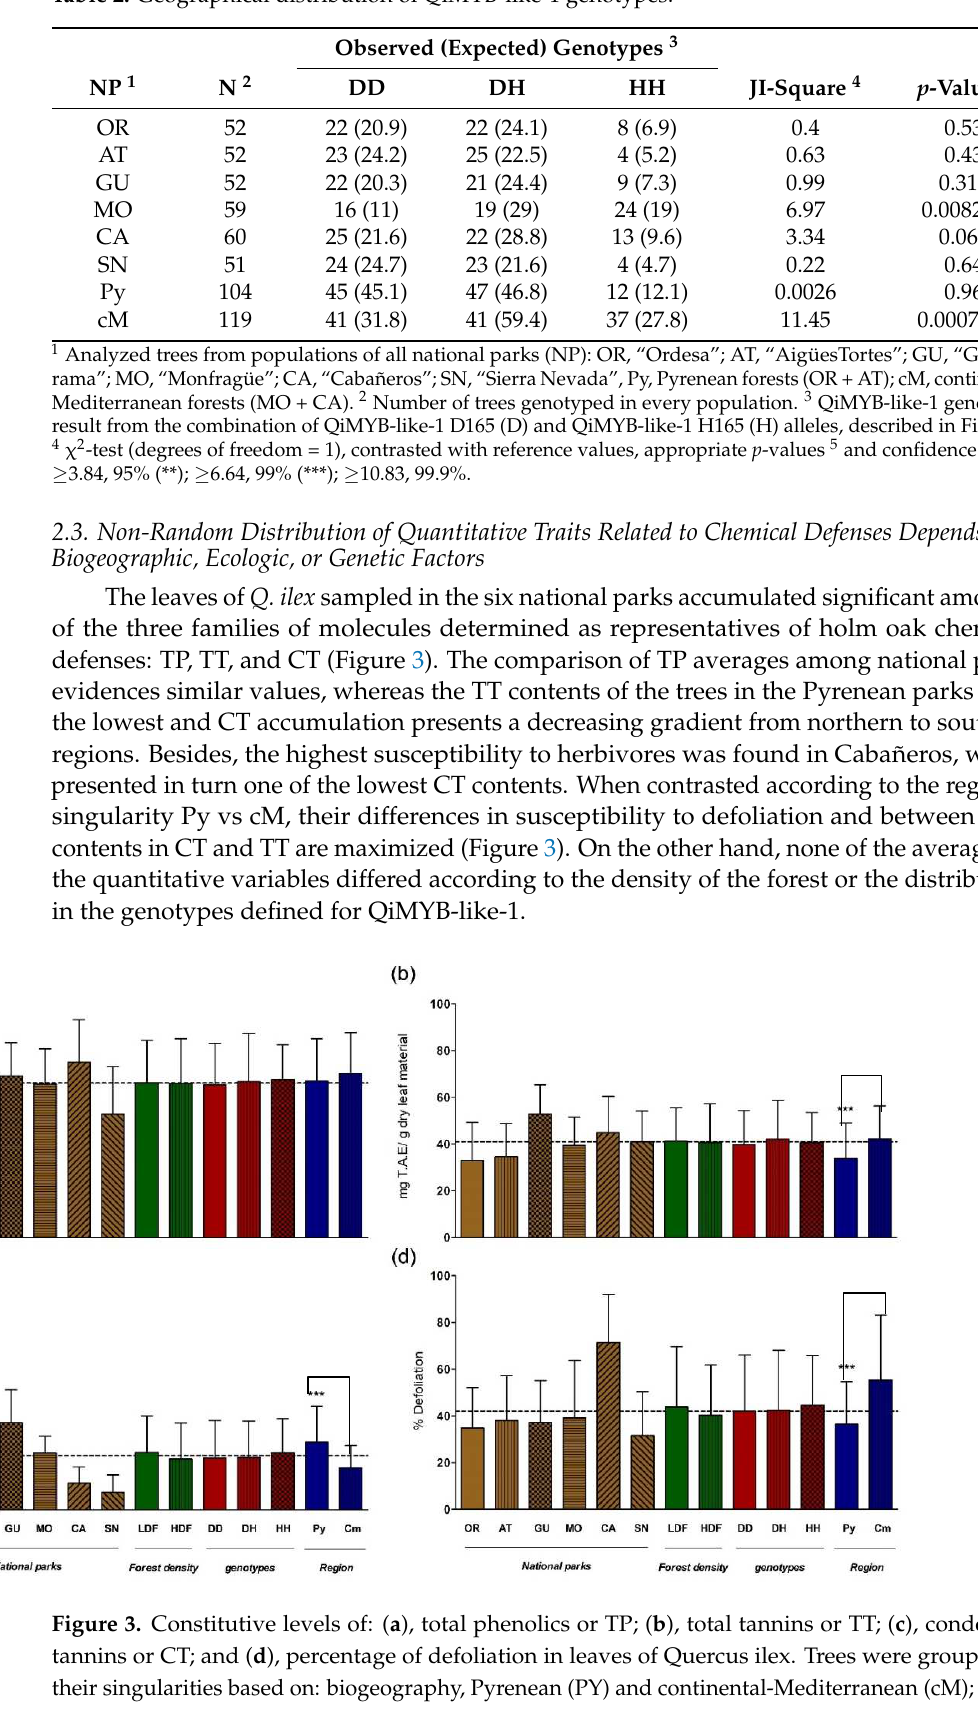
Table 2. Geographical distribution of QiMYB-like-1 genotypes.